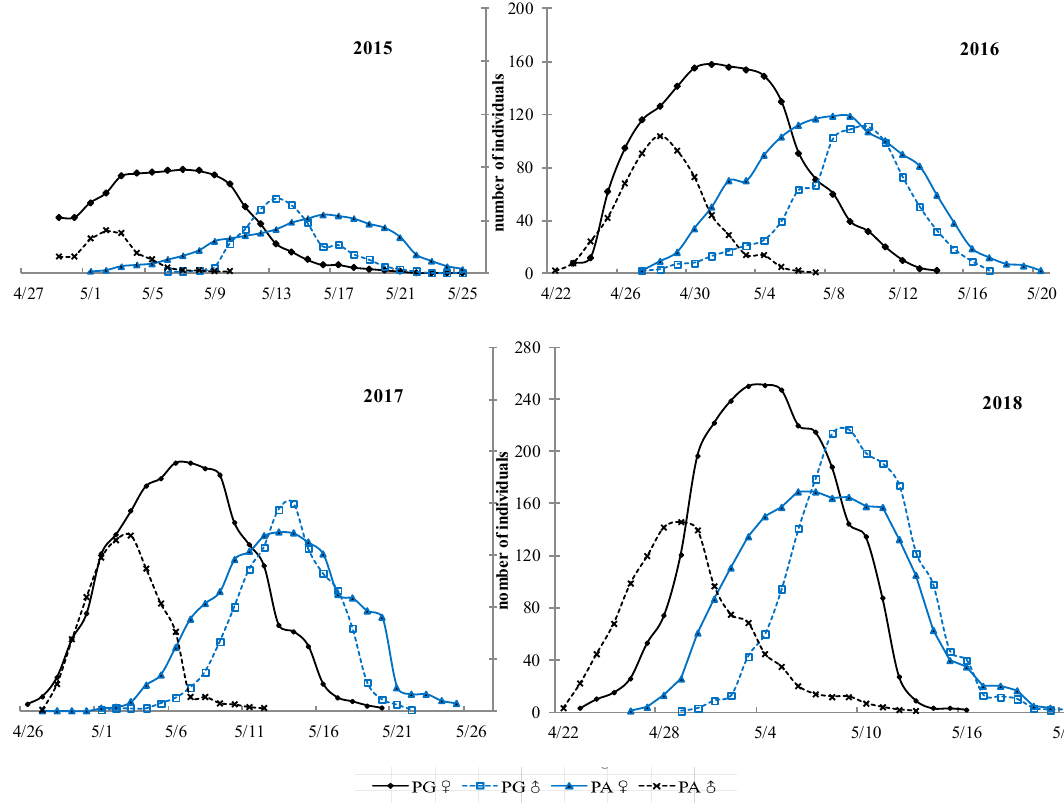
Figure 4. Number dynamic patterns of PA and PG flowering individuals in the population of C. paliurus during 2015–2018. The back lines describe the first flowering phase, while the blue lines describe the second phase. High overlap was obvious between the two phases and the two sexual functions within each phase.